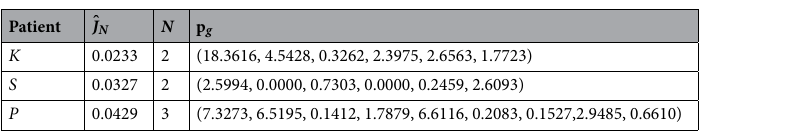
Table 2. Optimal functional value and optimal control parameters in the case of N -stage